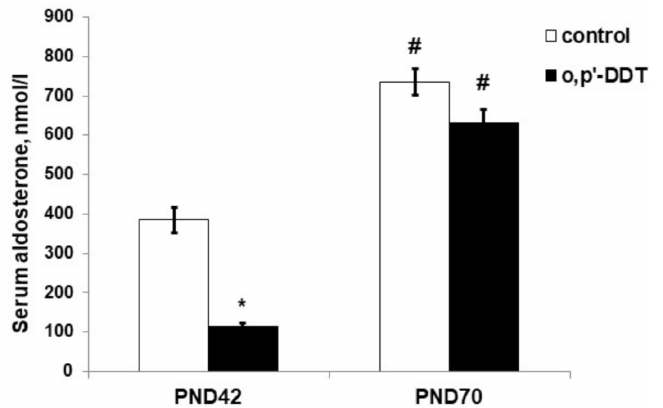
Figure 3. Aldosterone serum concentration in the control and o,p-DDT exposed rats. Data are shown as mean ± S.E.M. PND, day of postnatal development; p < 0.05 compared to the control (*), compared to PND42